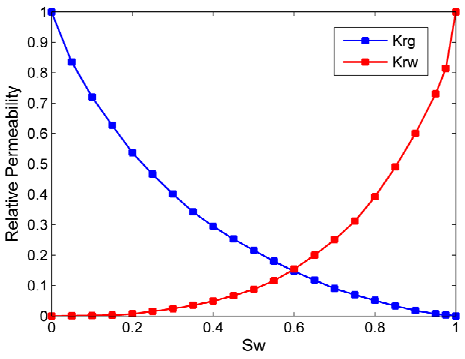
Figure 5. Production pattern of benchmark case.